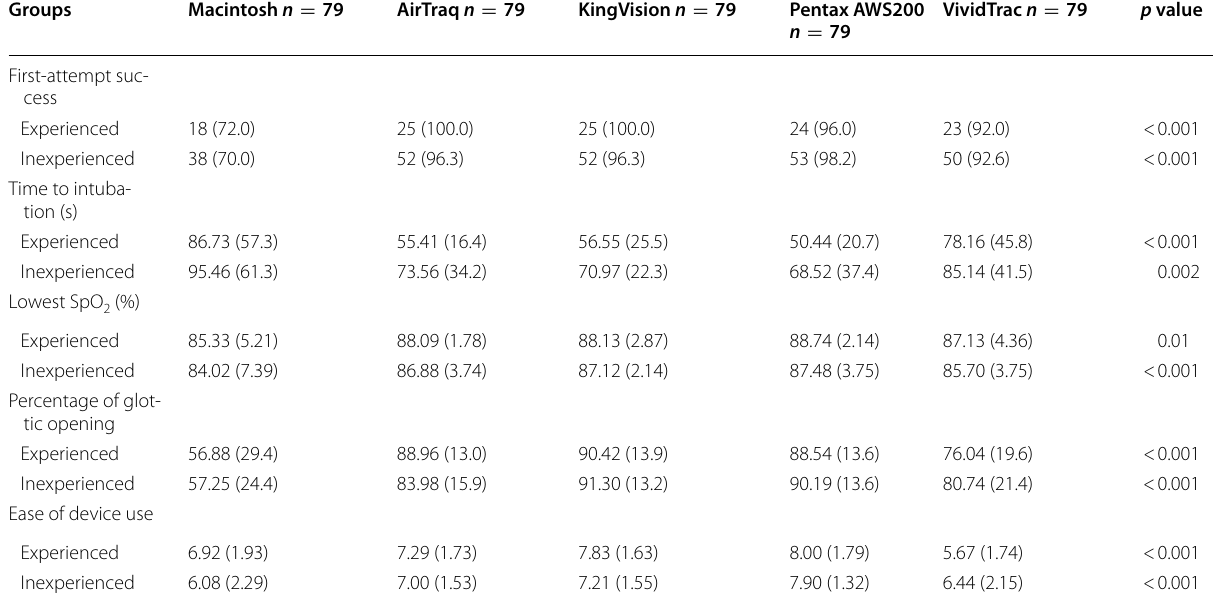
The data are the mean a Rated by the participants on a scale from 0 to